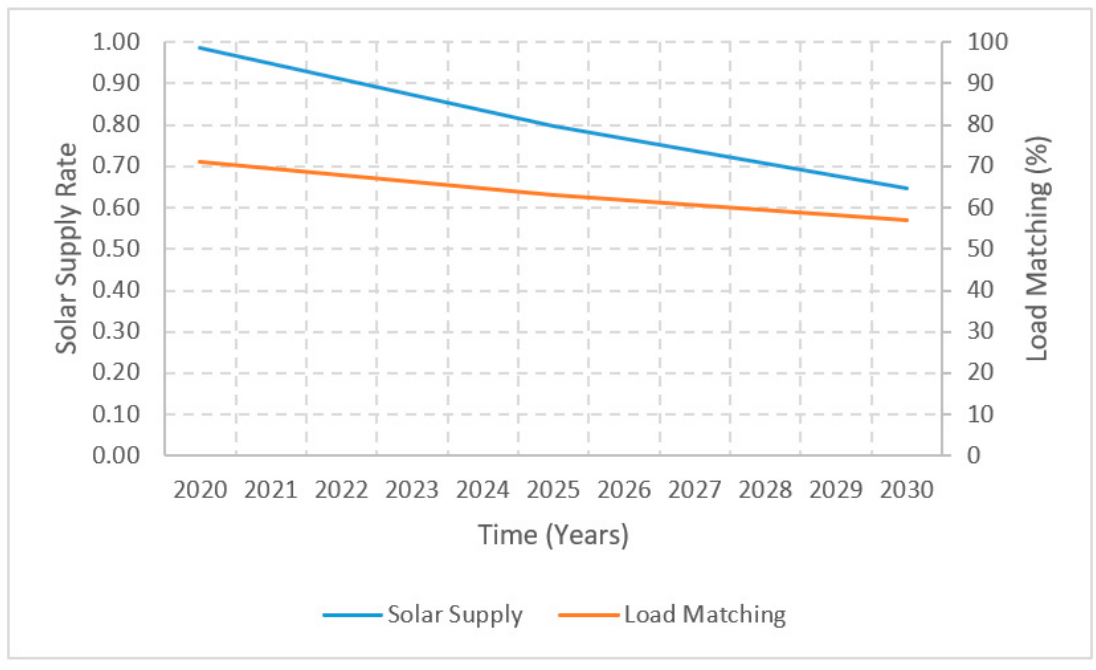
Figure 15. Solar supply rate and load matching.